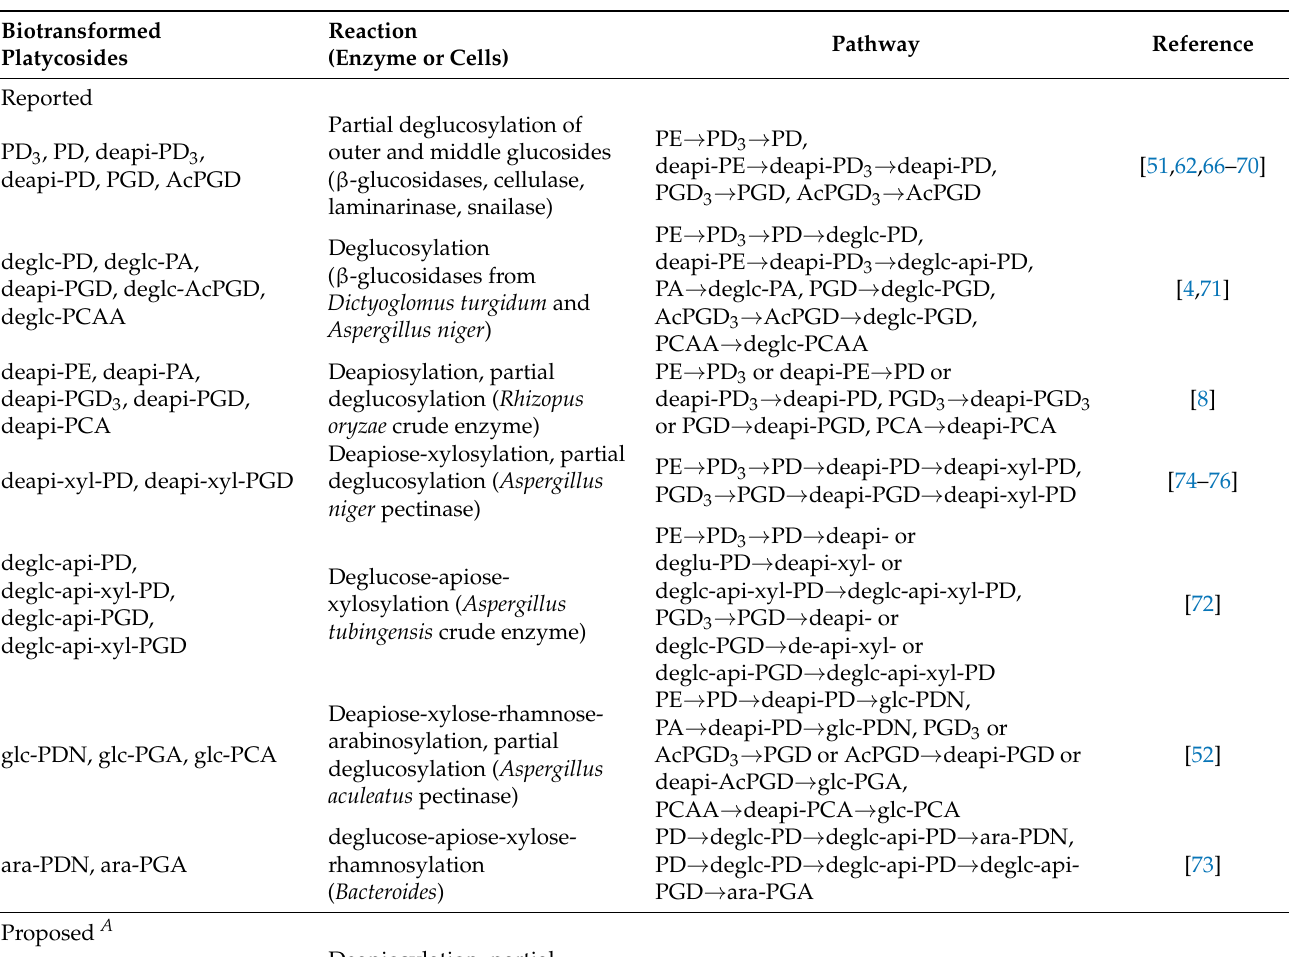
Table 1. Biosynthesis of biotransformed